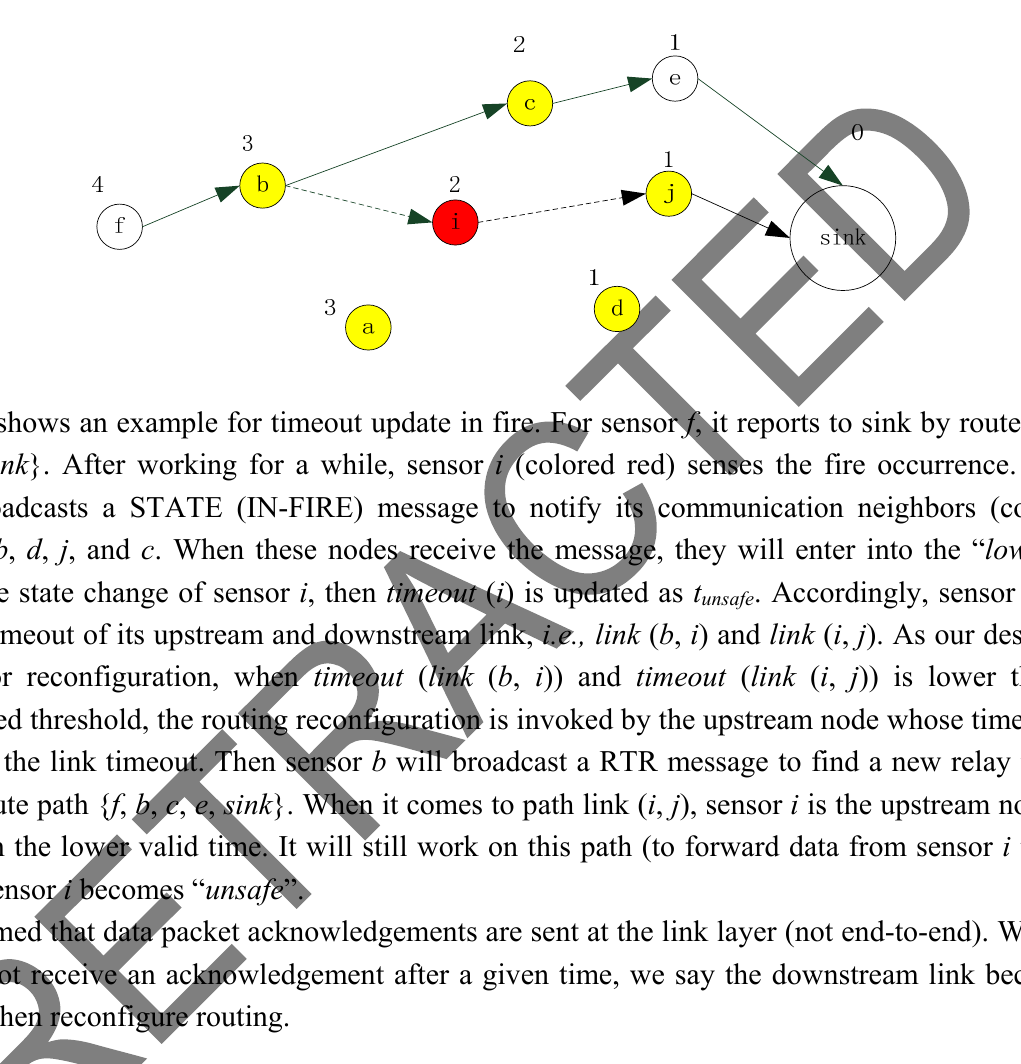
Figure 3. Timeout update in fire and route